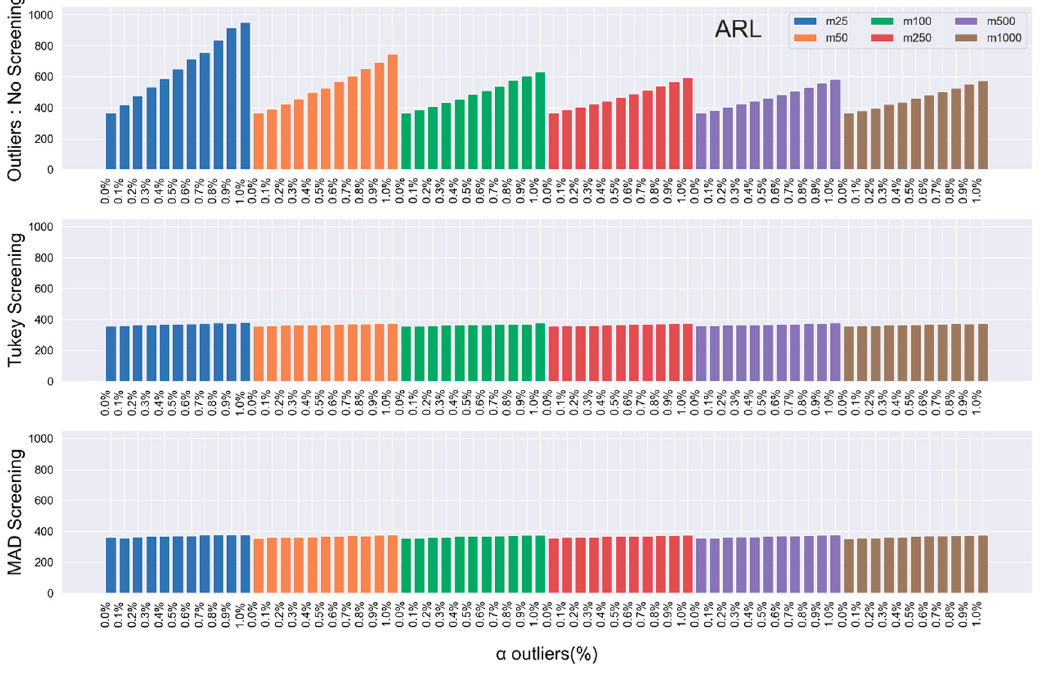
Figure 3. In-control ARL values for the Shewhart chart from t-( v = 100) distribution in the presence of outliers with and without outlier screening.